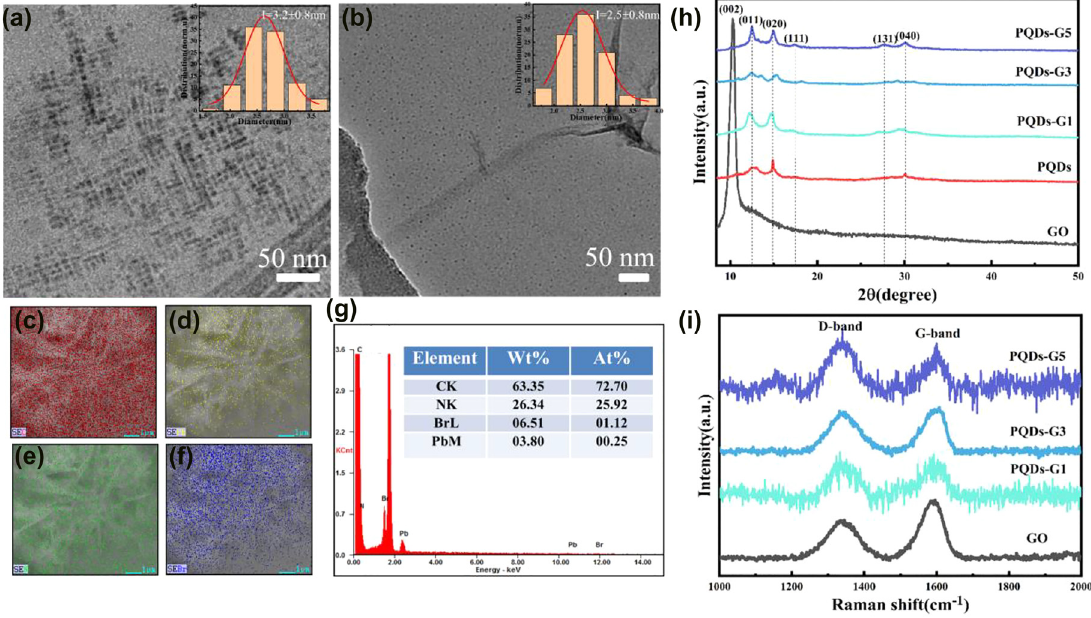
Figure 2: Typical TEM images of (a) PQDs, (b) PQDs-G5. The insets show the size statistics of quantum dots. (c)–(f) The elemental mappings of C, Pb, N, Br in PQDs-G. (g) EDS patterns of G-PQDs. (h) XRD spectra of GO, PQDs and PQDs-G composites. (i) Raman patterns of GO and PQDs-G